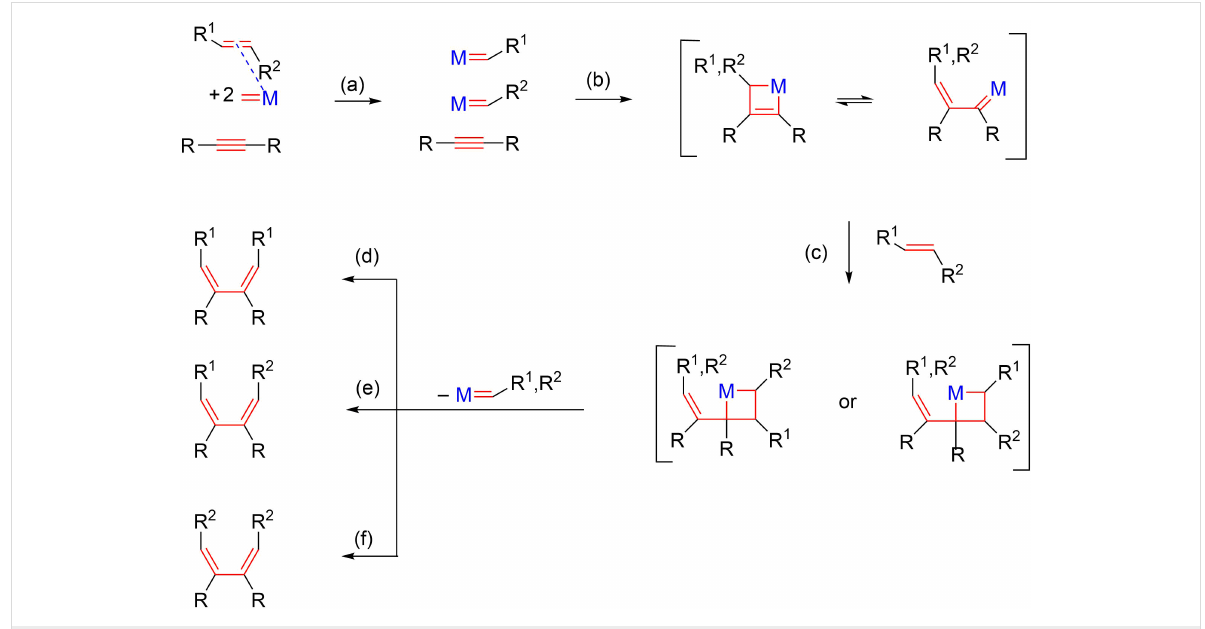
Scheme 3: Metallacarbene mechanism in intermolecular enyne